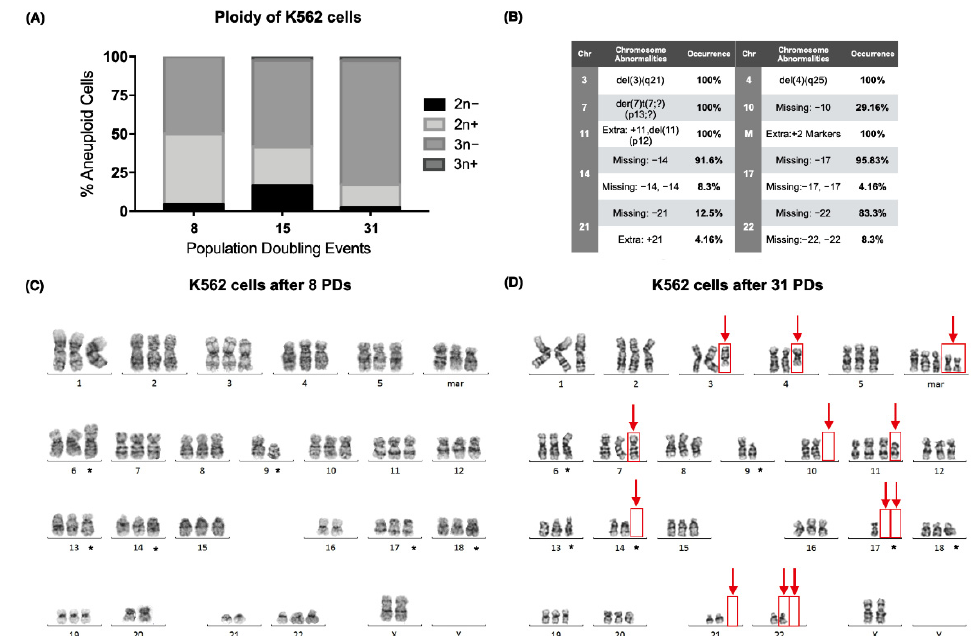
Figure 2. The hypotriploid K562 cell line displayed chromosomal instability as the culture aged. ( A ) Percentage of aneuploid cells after 8, 15, and 31 population-doubling events (PDs) in the K562 cell line. Over 50% of the analyzed cells were hypotriploid (3n − ) in the sampled PDs. ( B ) Table with the chromosomal abnormalities found after 31 PDs of the K562 cell line. A total of 14 numerical/structural chromosomal alterations were found; 8 of them occurred in more than 80% of the analyzed cells. ( C ) Karyogram of the K562 cells after 8 population-doubling events. The numerical or structural chromosomal alterations that were found in every sampled population are marked (*). ( D ) Karyogram of K562 cells after 31 population-doubling events. The numerical or structural chromosomal alterations that were found in every sampled population are marked (*). Additional chromosomal abnormalities are marked with red arrows.